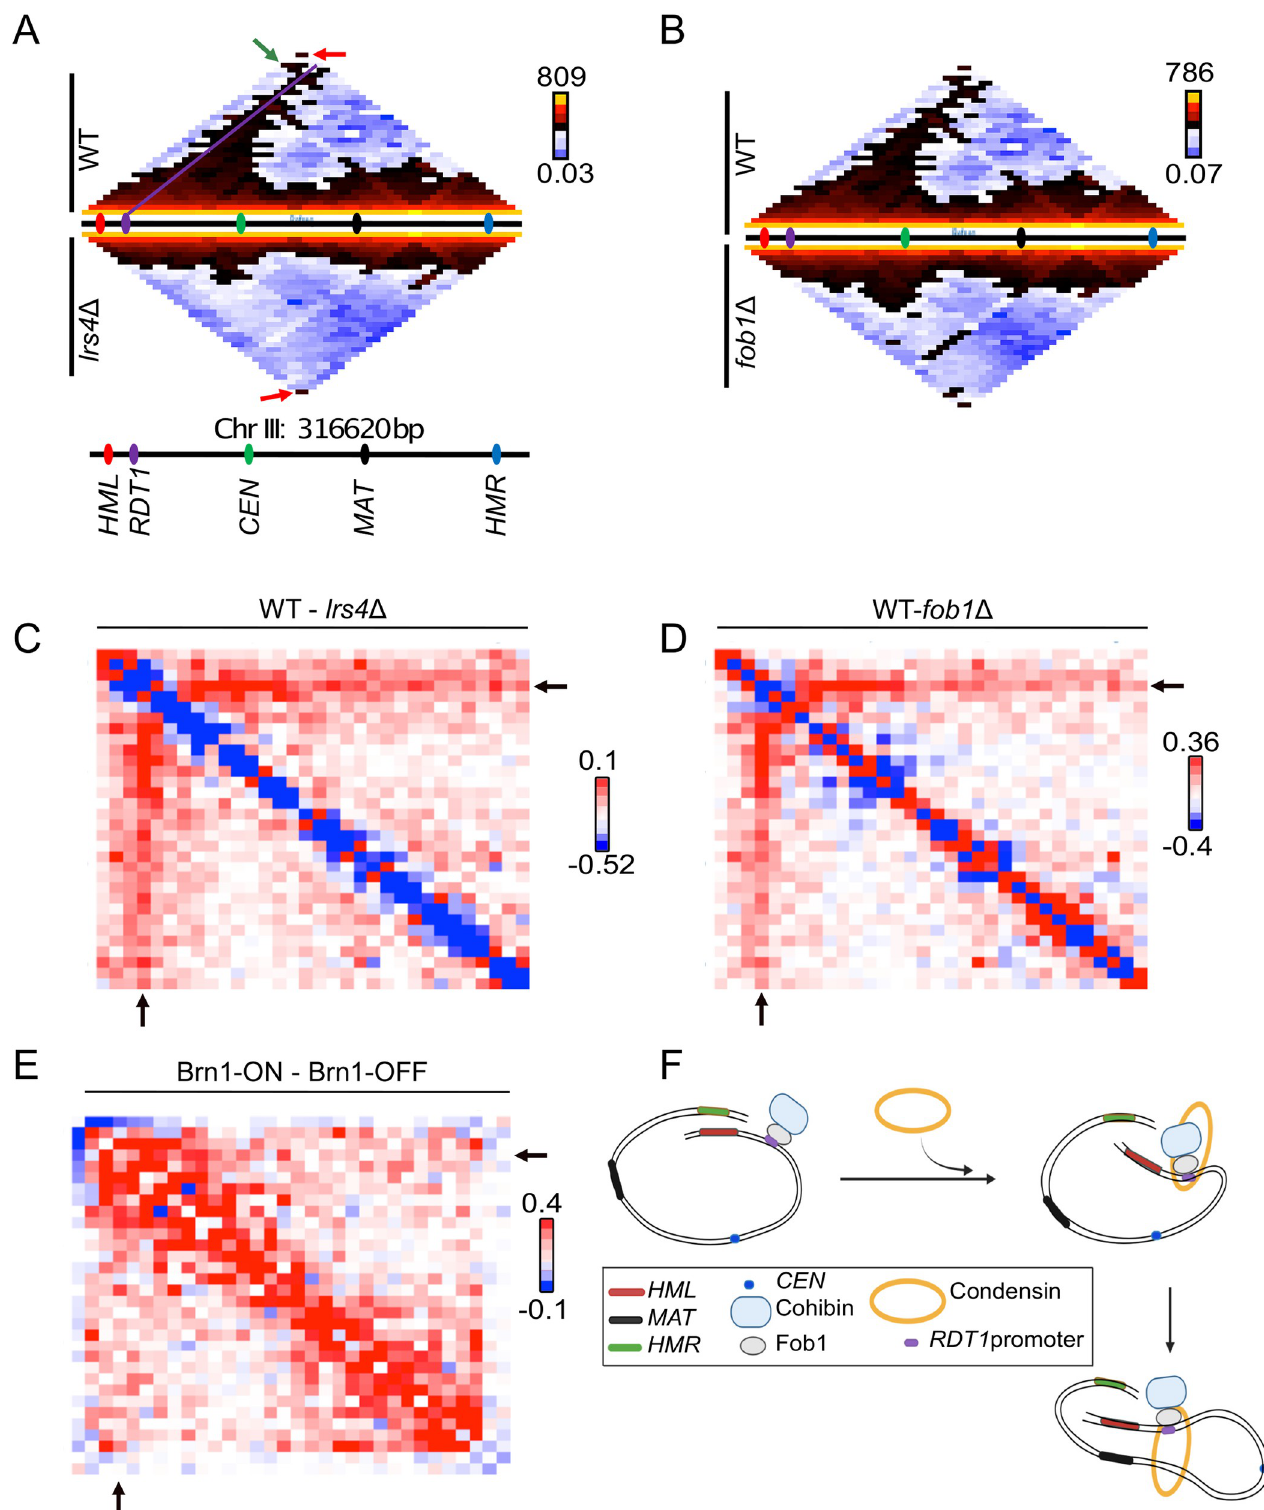
Fig 7. Lrs4, Fob1, and condensin control chromosome III conformation in MAT a cells. ( A ) Micro-C XL interaction heat map (iteratively corrected) for chromosome III at 10 kb resolution comparing WT (top) and lrs4 Δ (bottom) strains. In the WT map, a green arrow indicates the HML-HMR interaction,